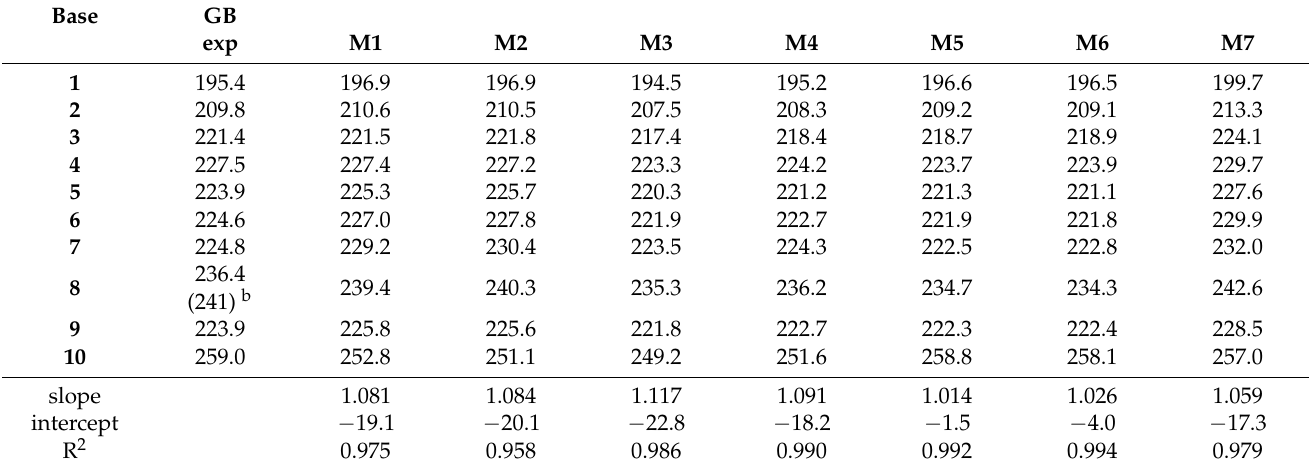
Table 1. Comparison of the experimental and calculated gas-phase basicity values for the selected phosphine bases a . Base